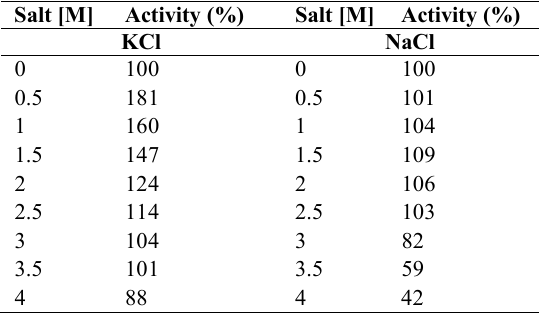
Table 2. Effect of various concentrations of NaCl and KCl on enzyme activity.